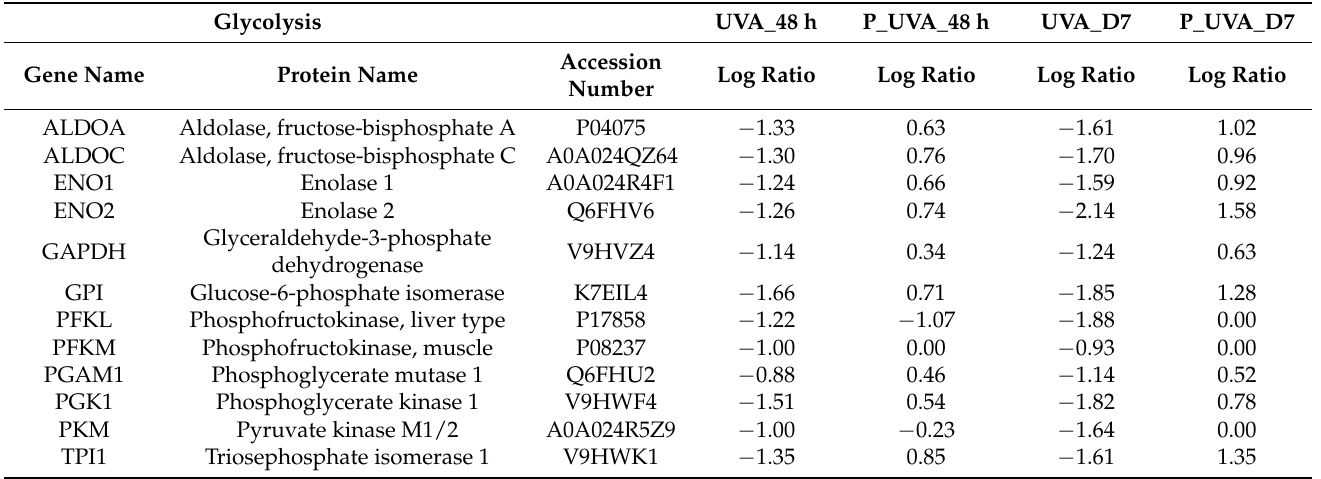
Table 5. Proteins involved in the Glycolysis